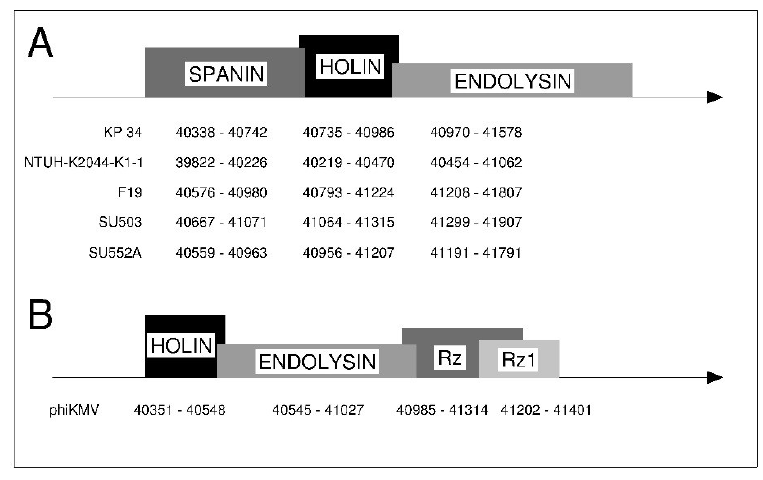
Figure 5. Lysis cassette scheme in the analyzed ( A ) “Kp34likevirus” and ( B )